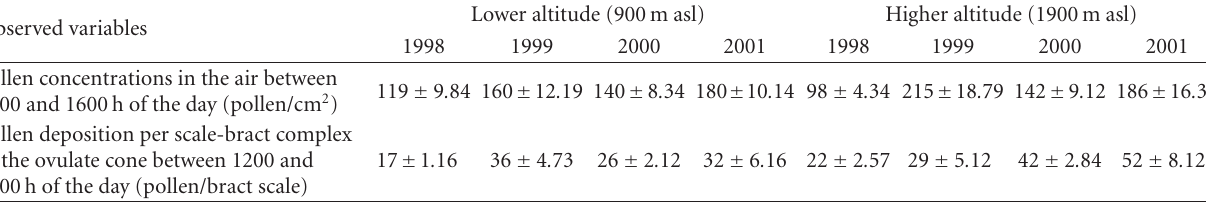
Table 4: Temporal and spatial variation in frequency of air borne pollen in P.